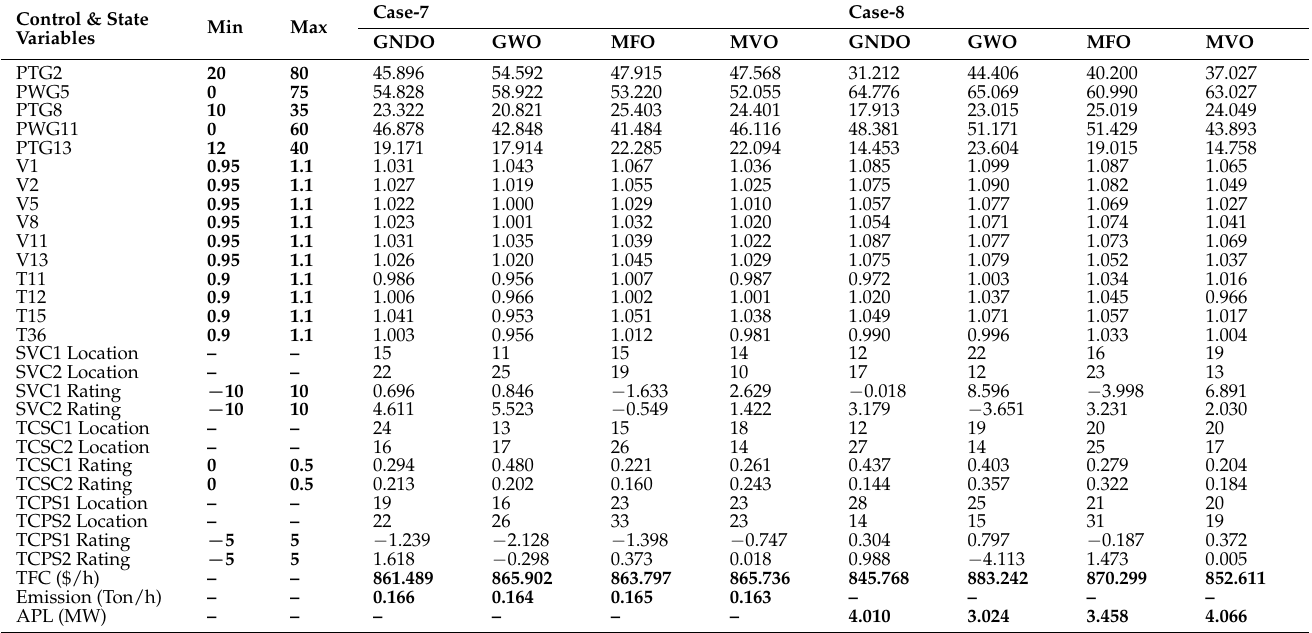
Table 13. Multi-objective simulation results for case 7 and case 8.